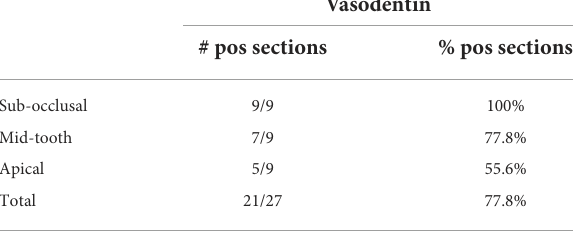
TABLE 2 Presence of vasodentin on a section level in nine alpaca cheek